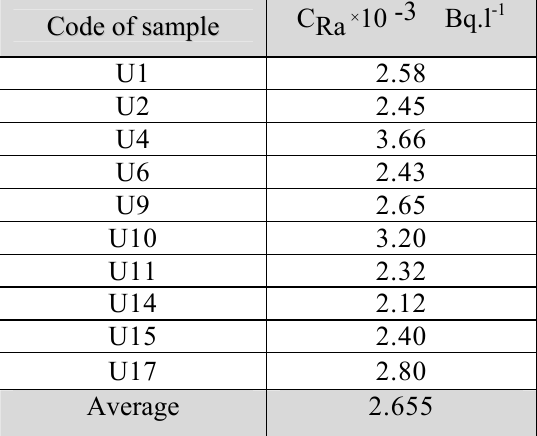
Table 5: Radon concentration in urine human of Baghdad samples.